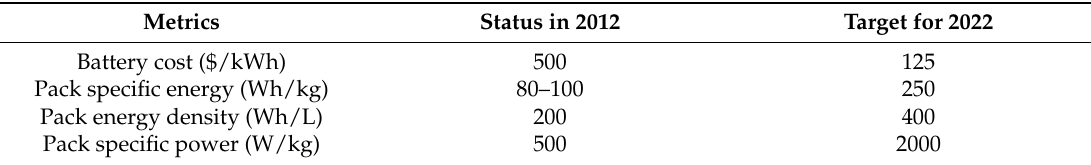
Table 2. The U.S. DOE “EV Everywhere” energy storage targets for battery systems